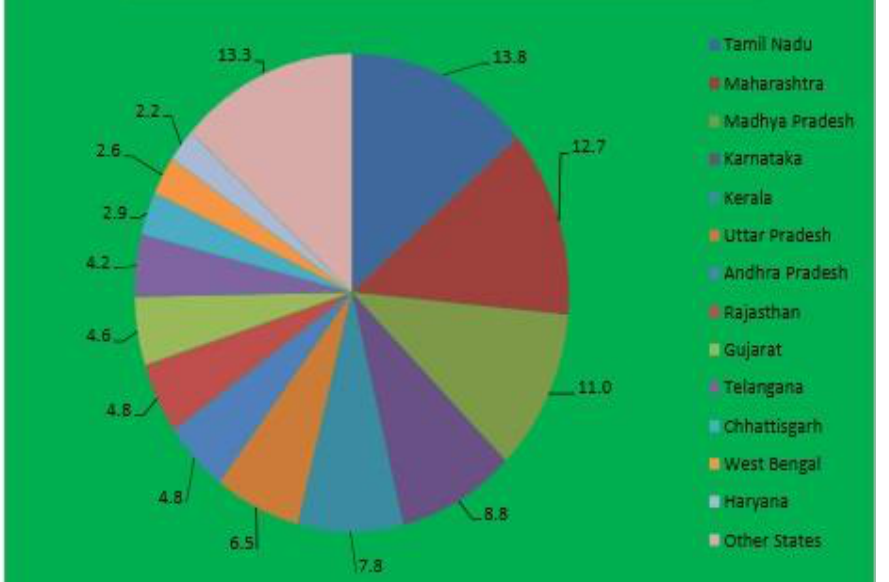
Fig. 2. Percentage number of road accidents in year 2015 [18]